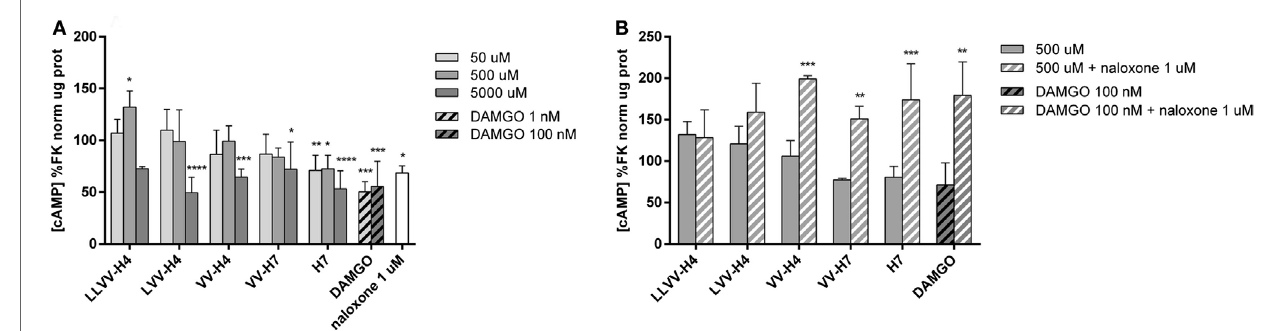
FigUre 7 | Determination of intracellular cAMP in forskolin (FK)-stimulated Caco-2 cells after incubation with the five hemorphins. (a) The ability of the hemorphins/ opioid peptides to act on the cAMP pathway was evaluated in vitro . Caco-2 cells were incubated with or without increasing concentrations of each hemorphin, DAMGO, a known specific OP agonist and naloxone, a known OP antagonist, in FK-supplemented medium for 15 min at 37°C. Intracellular cAMP levels were determined by ELISA, normalized by the total protein concentration and expressed as a percentage of the reference group FK. Data presented are mean ± SD (average of two assays performed in triplicate; n = 6). *Statistically different from control; * p < 0.05, ** p < 0.01, *** p < 0.005. (B) To determine whether the effect of the hemorphins was mediated through OPs, the same assay was performed with or without naloxone (1 µM) in the same incubation medium. Data presented are mean ± SD ( n = 3). *Statistically different from control; ** p < 0.01, *** p < 0.005.